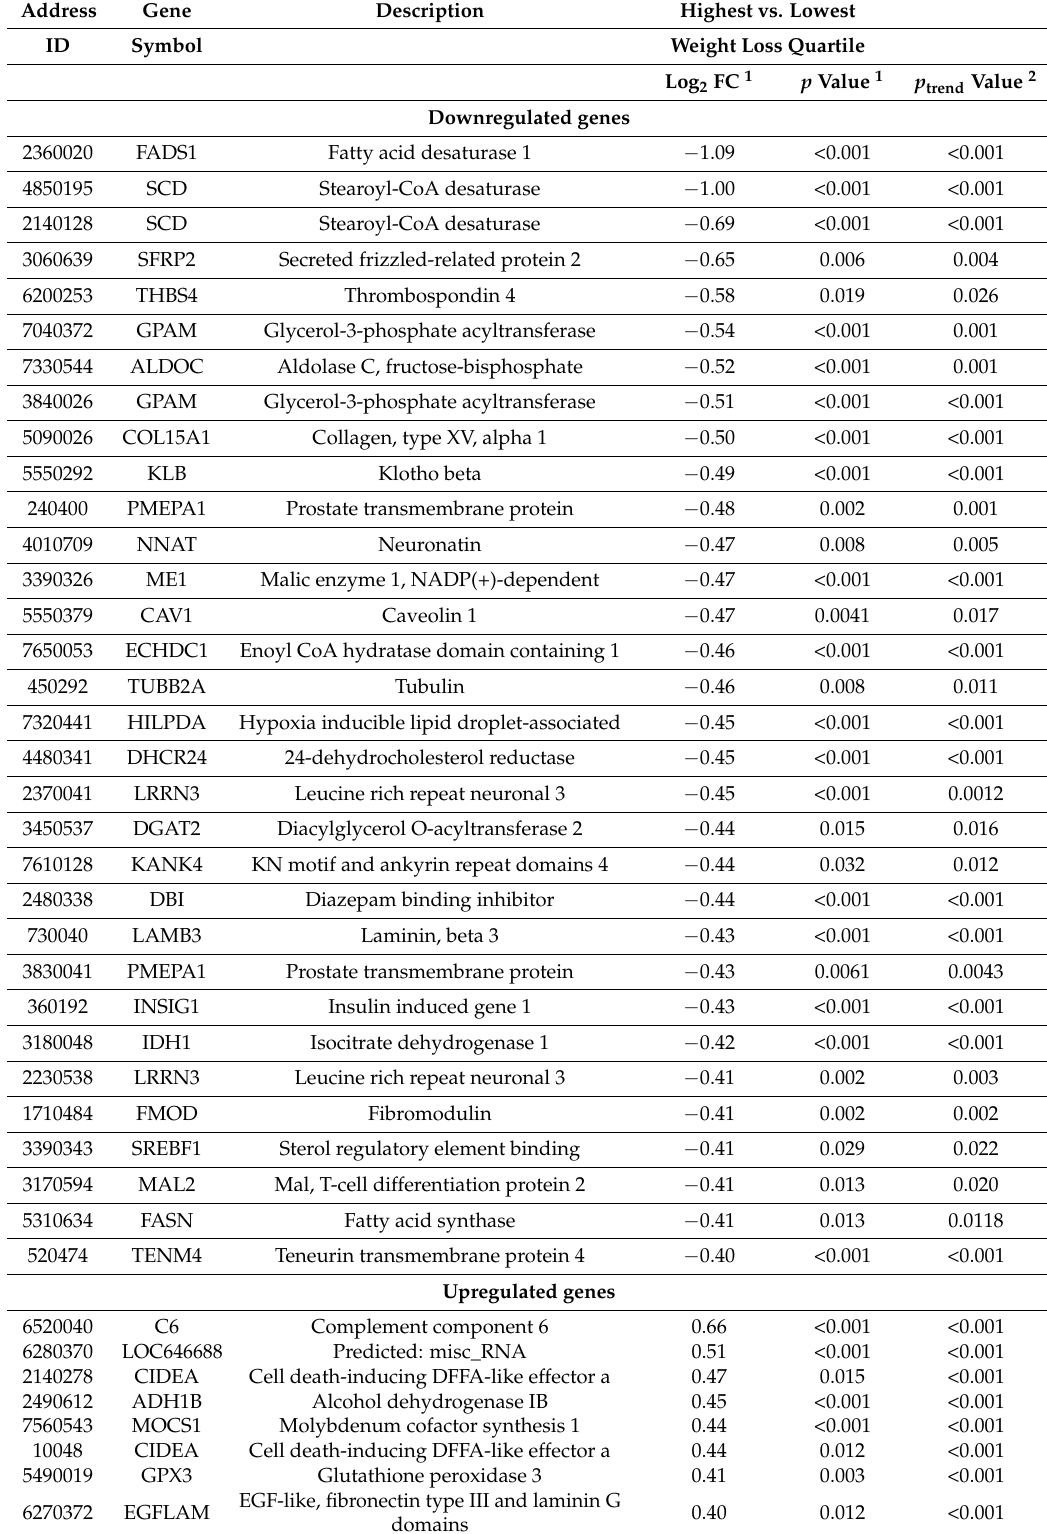
Table 2. Up- and downregulated genes ( p -value < 0.05; log 2 fold change >0.4) for comparisons between highest- and lowest weight loss quartile ( n =